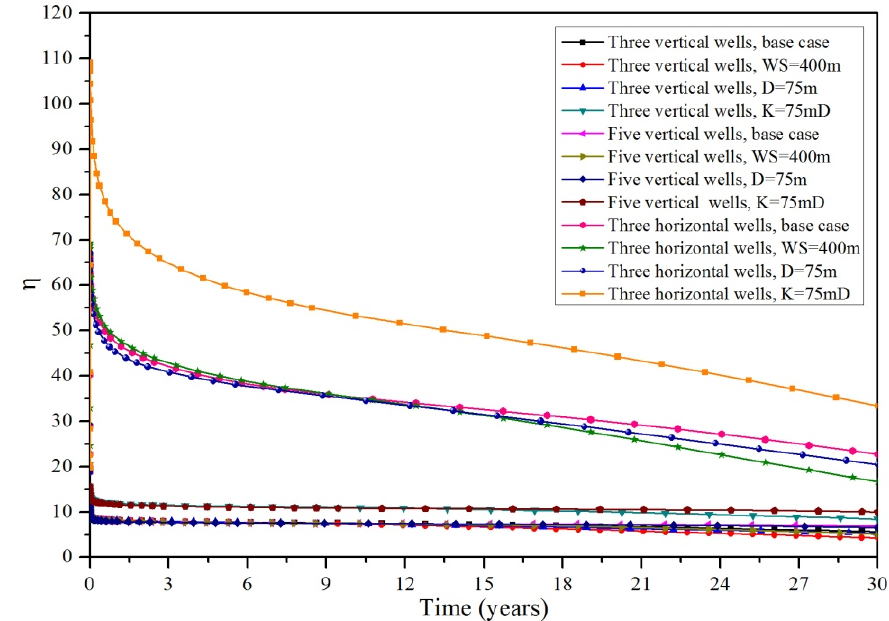
Figure 11. Sensitivity of energy efficiency to main parameters.